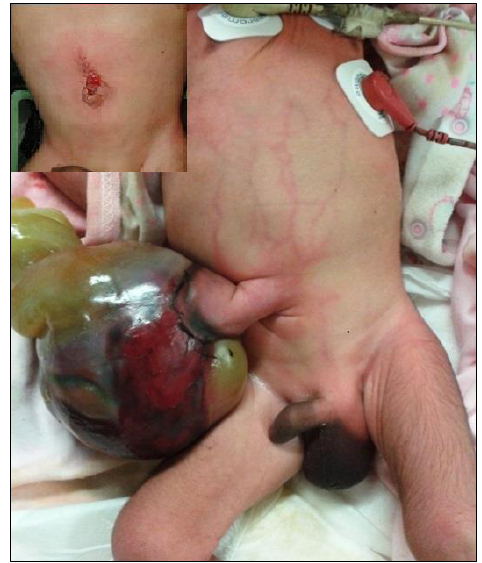
Figure 1: Hernia of umbilical cord with large sac and dark maroon discoloration. Inset showed post-repair